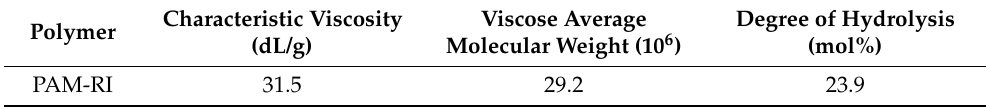
Table 1. Determination of the basic physical properties of the PAM-RI polymer.